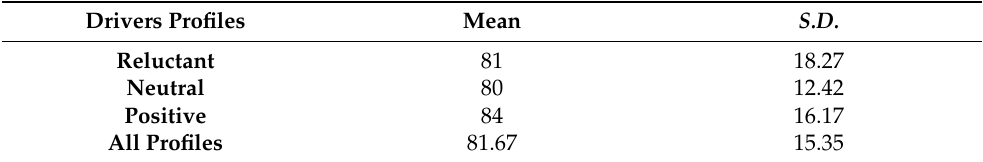
Table 2. SUS score results for each profile of drivers.